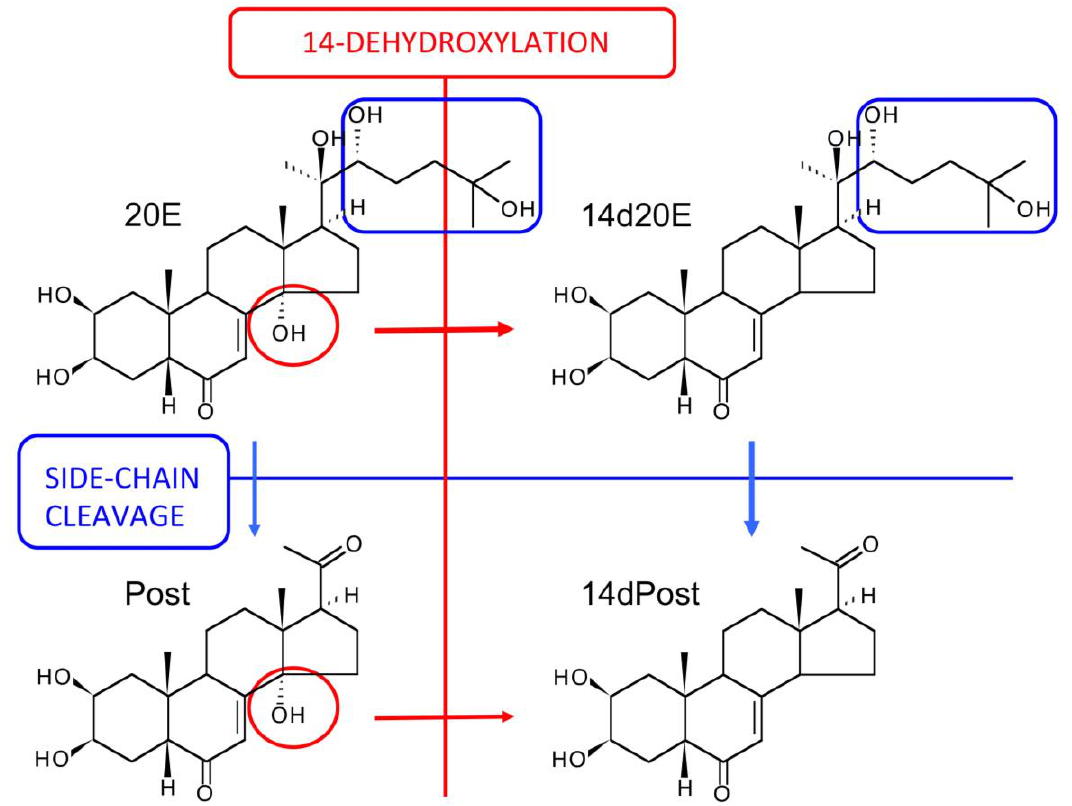
Figure 10. The principal routes of metabolism of 20E in rodents and humans (modified from Kumpun et al., 2011). The circles and arrows in red highlight the changes associated with 14-dehydroxylation, while the boxes and arrows in blue highlight the changes associated with side-chain cleavage.